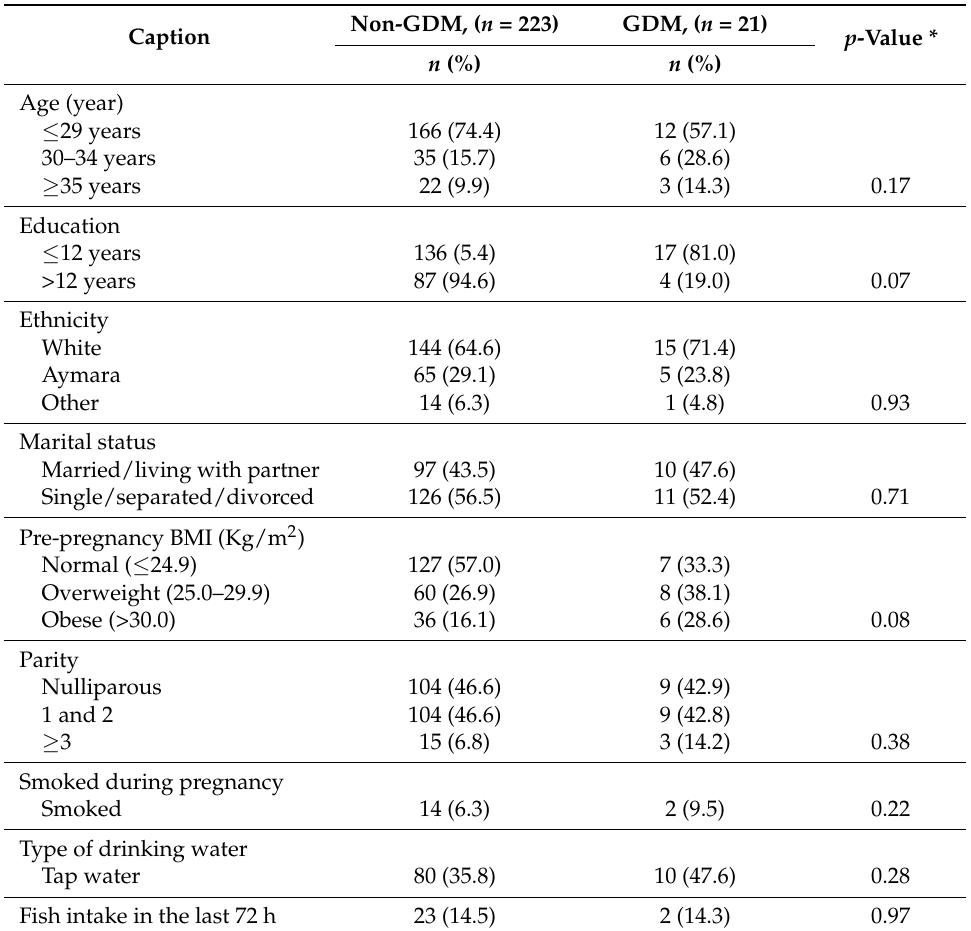
Table 1. Characteristics of pregnant women according to gestational diabetes mellitus (GDM) status, Arica 2013–2014.